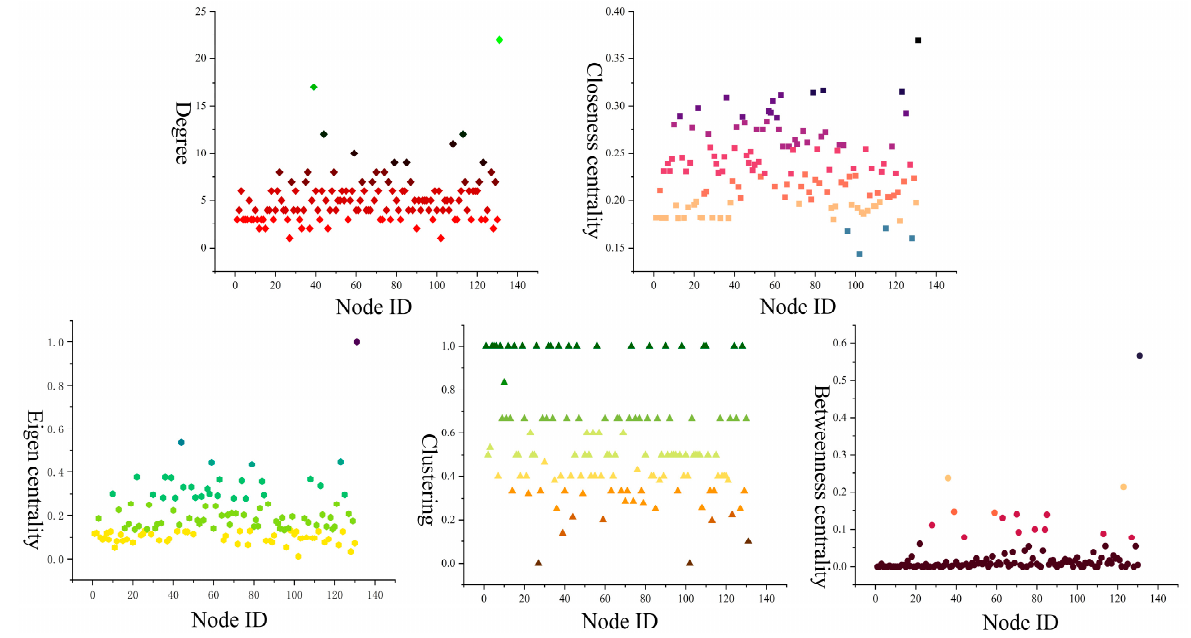
Figure 12. Topology metrics.